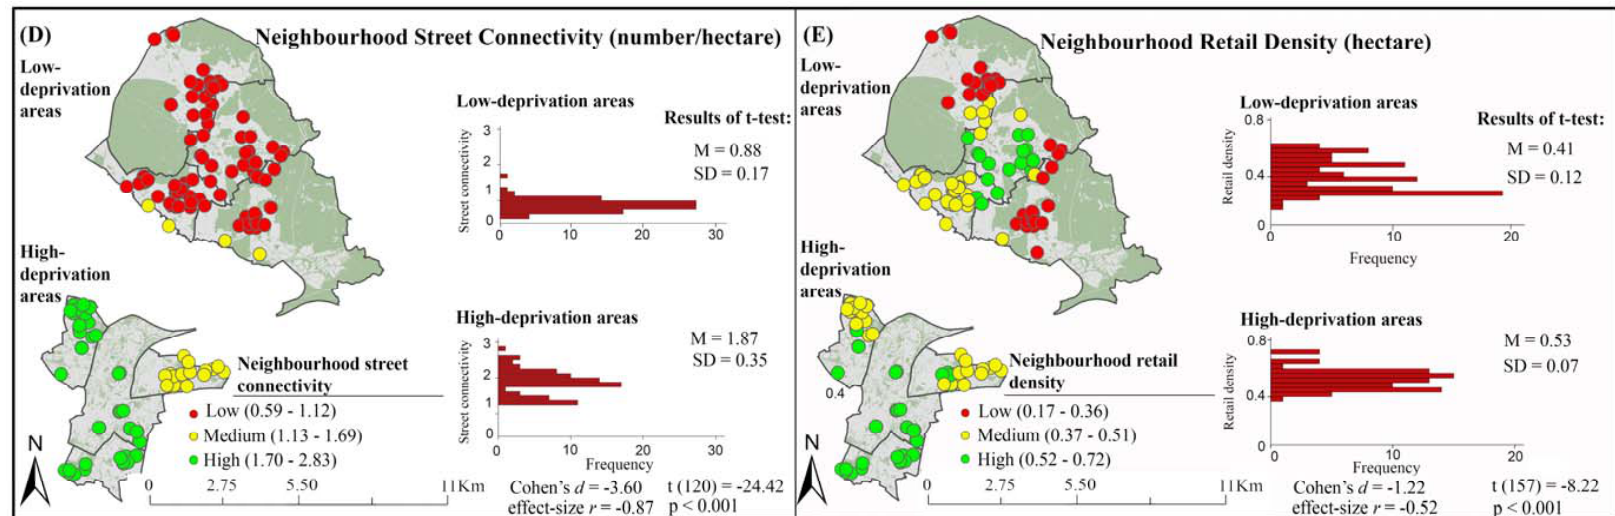
Figure 2. Disparities in outdoor walking levels and inequalities in objectively measured neighborhood built environment attributes (OS open data Boundary ‐ line © Crown copyright/database right 2012 and OS MasterMap data © Crown Copyright/database right 2016. An Ordnance Survey/EDINA Digimap supplied service). Data on outdoor walking levels (box A) is from [37]. Each point shows location of a participant’s home. Frequency = number of participants; M = Mean; SD = Standard Deviation; t = t ‐ value.